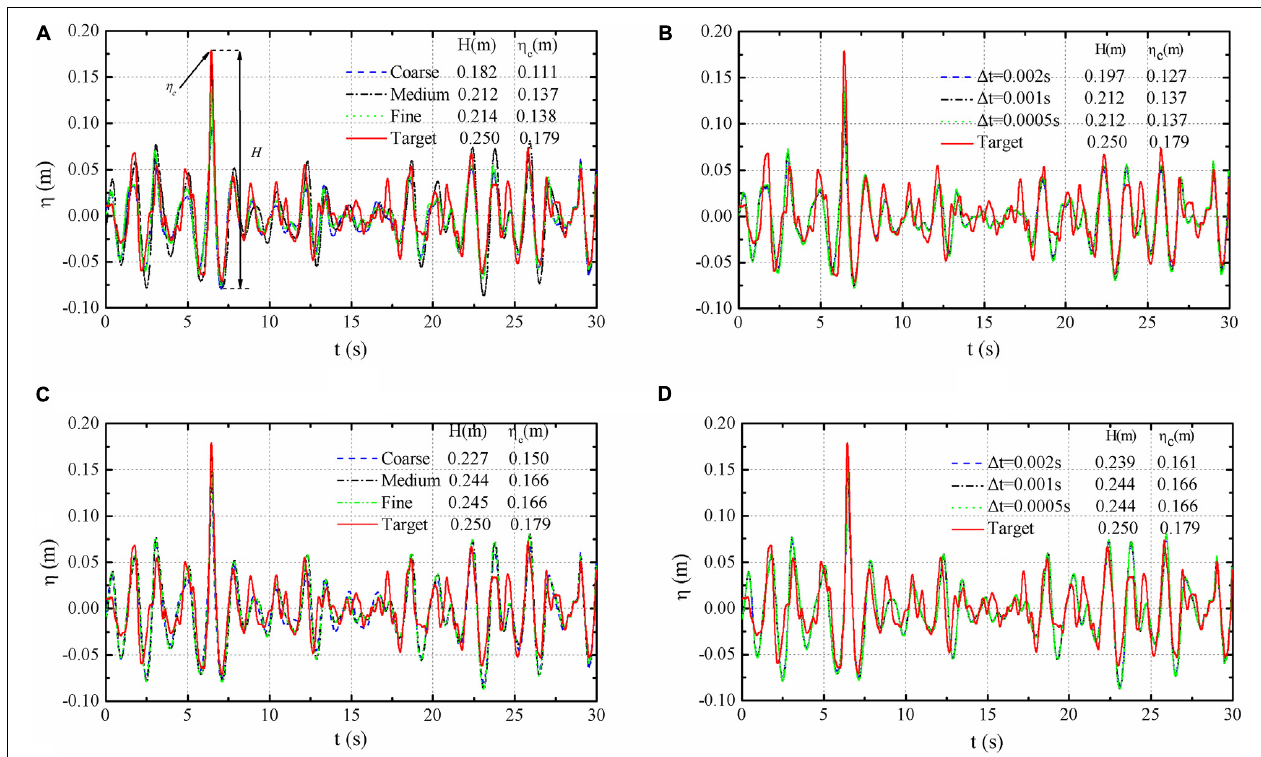
FIGURE 3 | Grid and time-step refinement results. (A) Non-modified grid convergence, (B) non-modified time-step convergence, (C) modified grid convergence, and (D) modified time-step convergence.